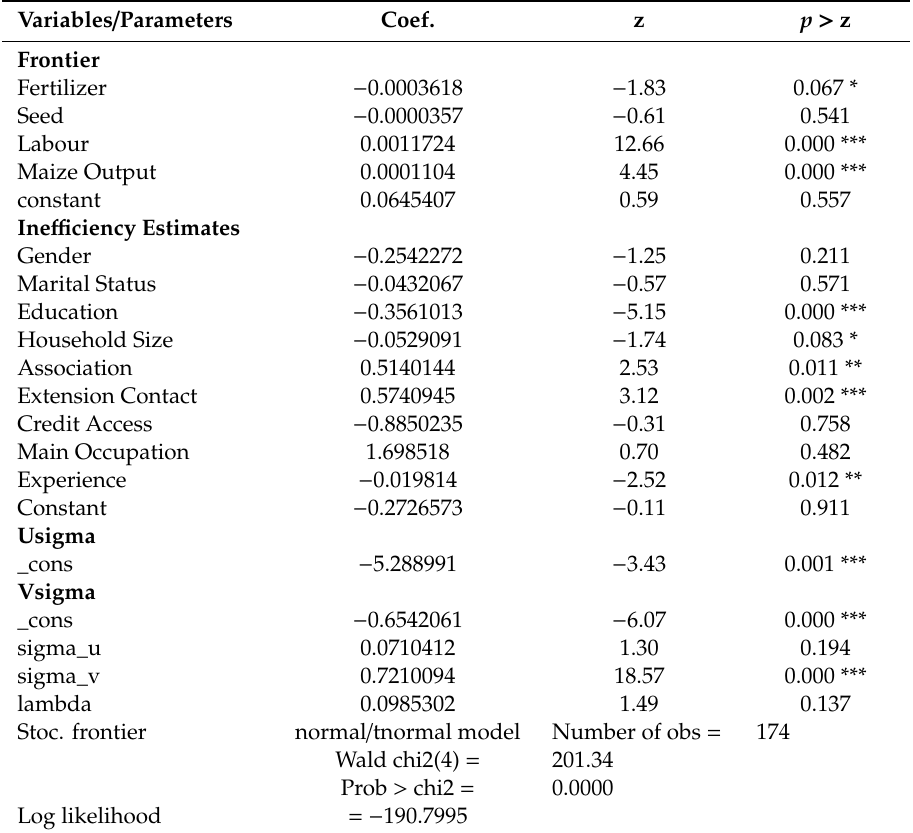
Table 4. One-step technical e ffi ciency and ine ffi ciency estimates for maize in Eastern Cape Province. Variables / Parameters